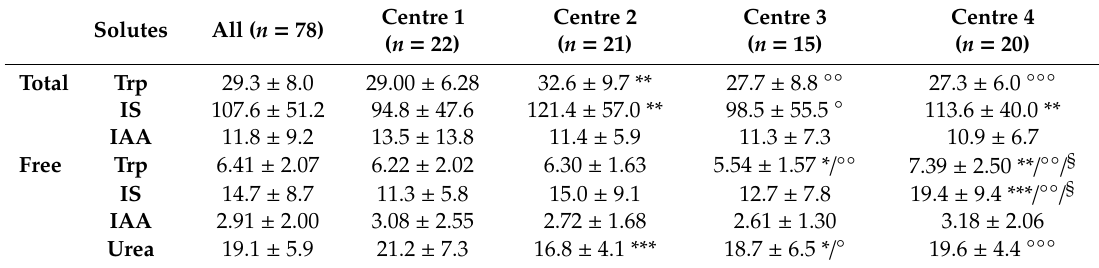
Table 1. Mean pre-dialysis serum solute concentrations and standard deviations of patients by centre (in µ mol / L, except for urea in mmol / L) 1